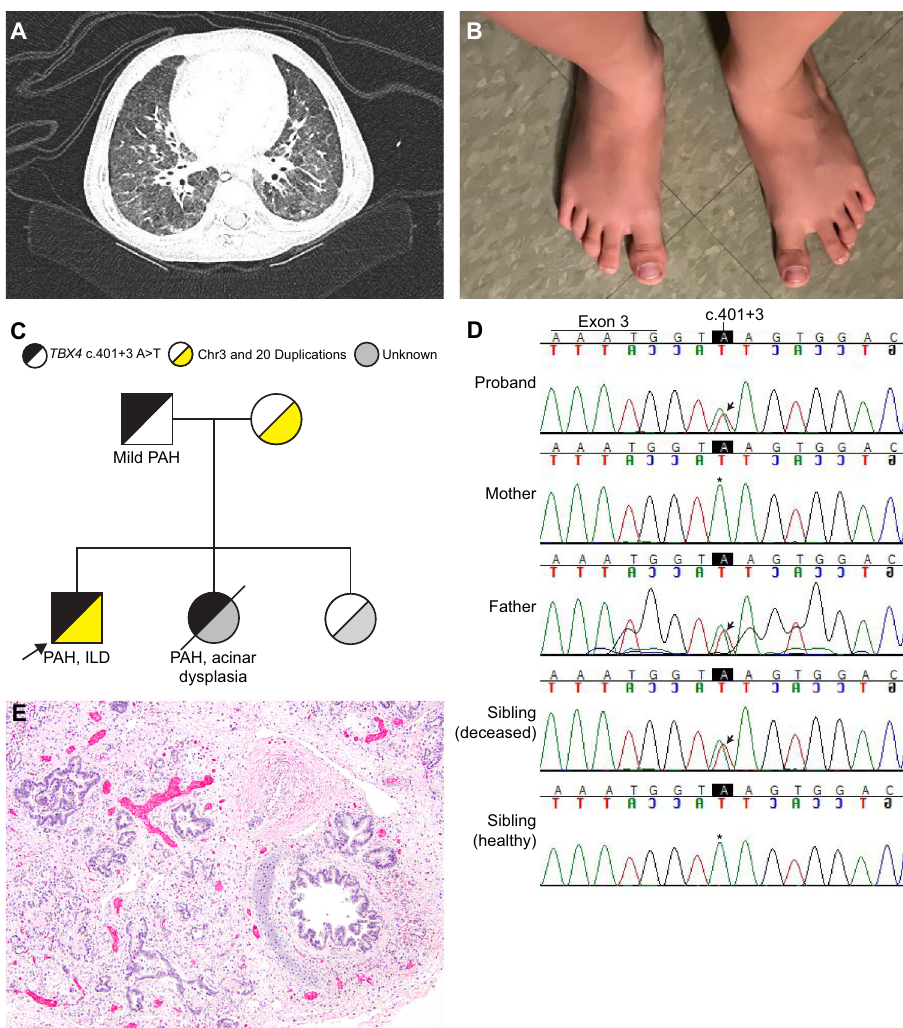
Fig. 1 Clinical features of proband with TBX4 intronic variant. A Chest CT at age 15 months showing perihilar peribronchial wall thickening with a paucity of peripheral lung markings. B Feet morphology showing widely spaced fi rst and second toes bilaterally. C Family pedigree demonstrating inheritance of the TBX4 c.401 + 3 A > T variant and the chromosome 3 and 20 duplications. Arrow denotes the proband. Abbreviations: PAH, pulmonary arterial hypertension; ILD, interstitial lung disease. D Sanger sequencing of TBX4 in family. Arrows depict the c.401 + 3 A > T variant in the proband, father, and deceased sibling. The * denotes the typical sequence in the mother and healthy sister. E Postmortem lung showing nearly absent alveolar development in the proband ’ s sister, who died at 2 days of age (hematoxylin and eosin; original magni fi cation,